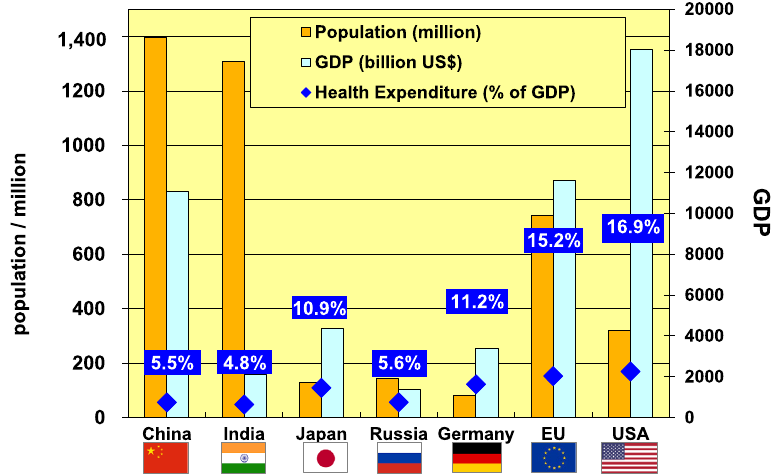
Figure 3. Population, GDP, and percentage health expenditure in various regions, October 2017. Author ’ s calculations [ according to [13 – 16]].